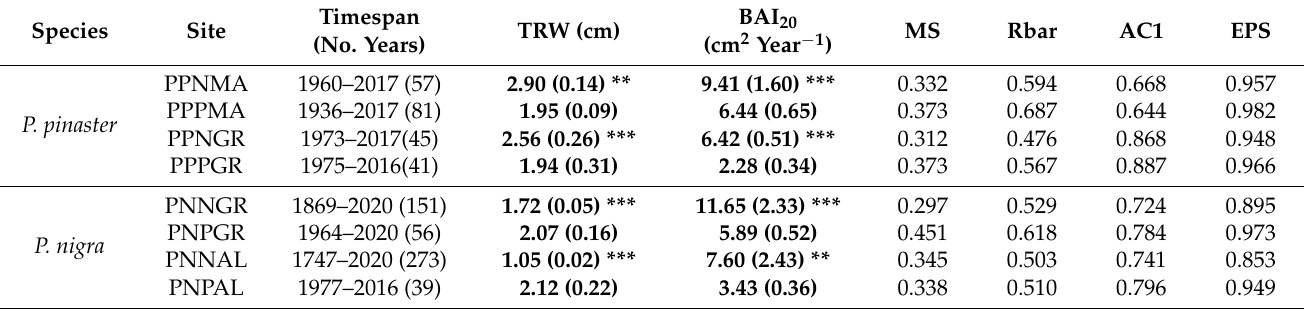
Table 2. Dendrochronological statistics of sampled Pinus pinaster and P. nigra forests sampled across an aridity gradient in southeastern Spain. Sampled sites correspond to P. pinaster (PP) and P. nigra (PN) natural (PPN and PNN) and planted (PNP and PPP) stands. Abbreviations: Spp, specie; Site, PPNMA, P. pinaster natural (M á laga); PPPMA, P. pinaster planted (M á laga); PPNGR, P. pinaster natural (Granada); PPPGR, P. pinaster planted (Granada); PNNGR, P. nigra natural (Granada); PNPGR, P. nigra planted (Granada); PNNAL, P. nigra natural (Almer í a) and PNPAL, P. nigra planted (Almer í a); TRW, tree-ring width; BAI20, mean basal area increment in the last 20 years; MS, Mean sensitivity; Rbar, mean correlation among series; AC1, first-order autocorrelation; EPS, Expressed Population Signal. Values are means ± standard errors (in brackets) Bold values show significant differences among